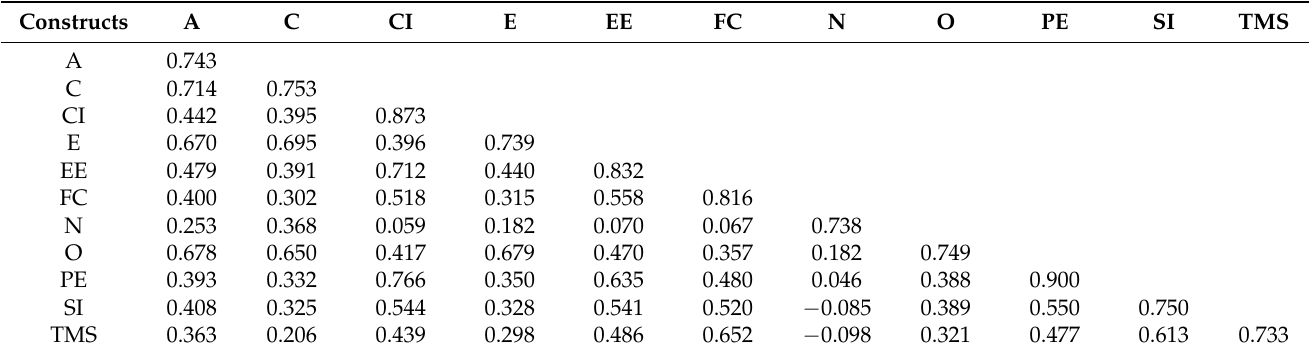
Table 4. Latent Variable Correlations and Square Roots of Average Variance